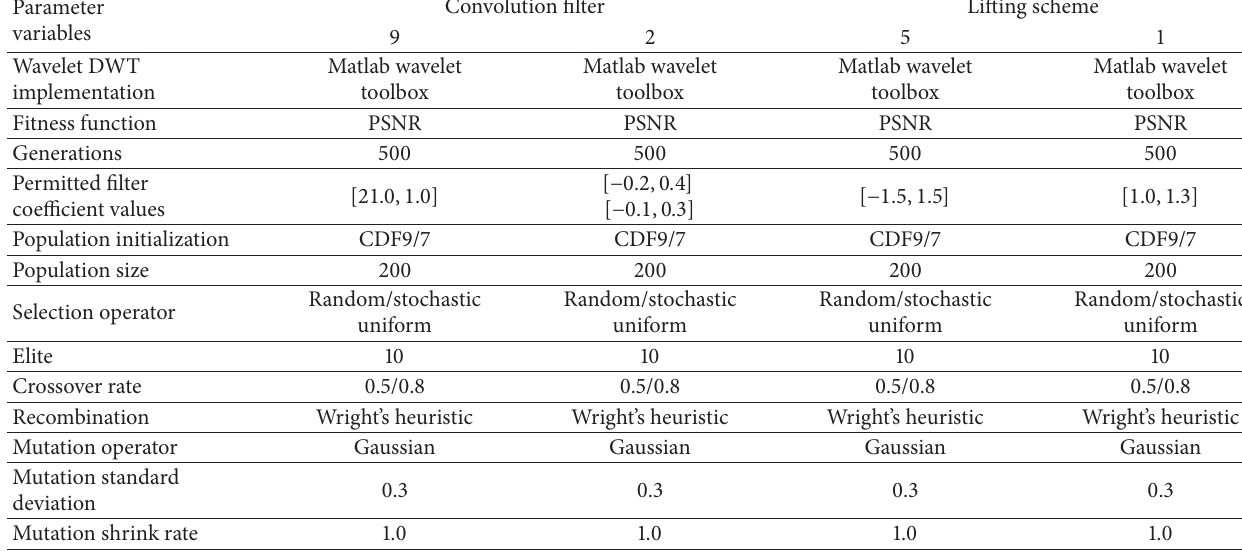
Table 3: Initial configuration of four different GAs.